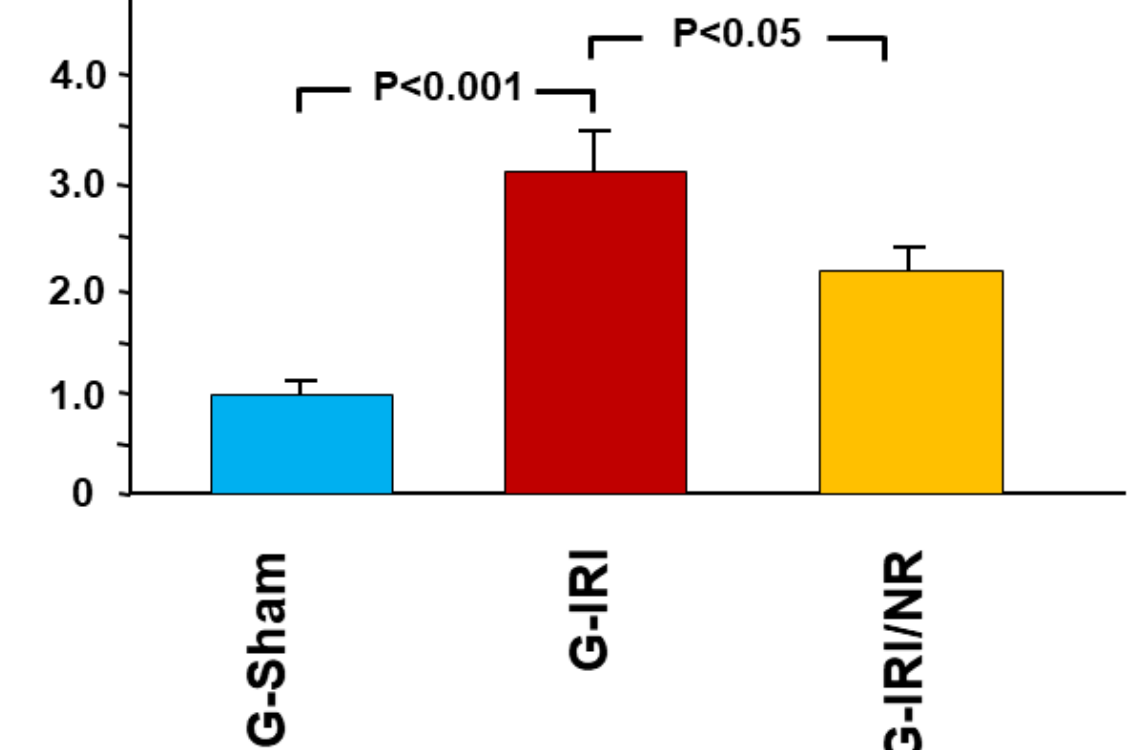
Figure 5. Gene expression of the proapoptotic p53 gene and procollagen-1 (COLA-1) in all groups. Values represent mean ± SEM.